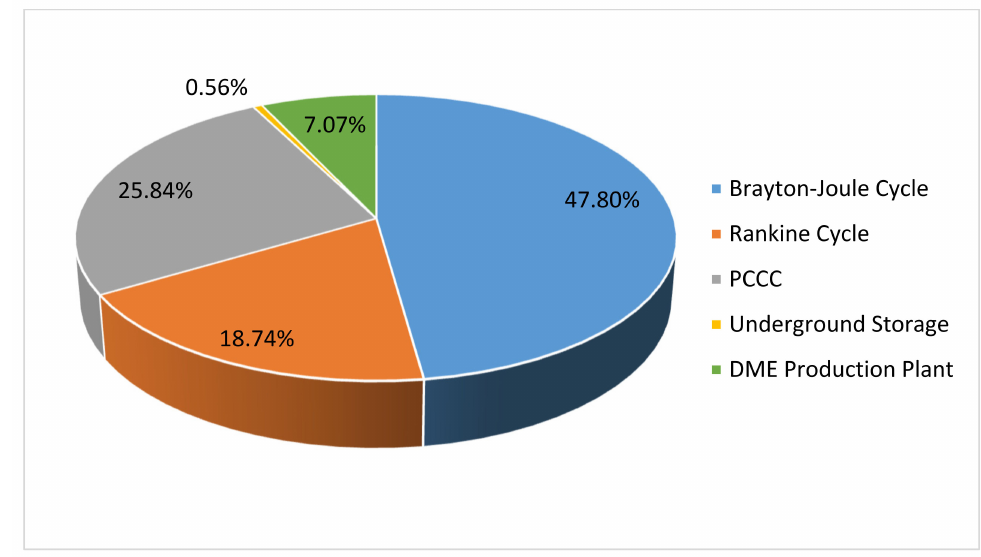
Figure 10. Distribution of exergy destruction between the units (total E D = 581.43 MW).